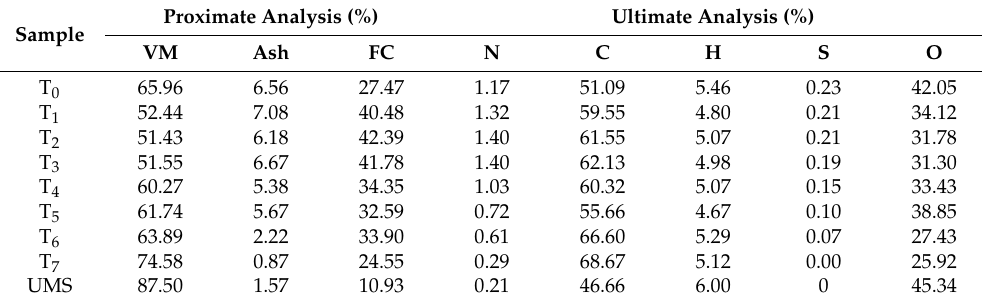
Table 2. Physicochemical properties of untreated and treated feedstock.